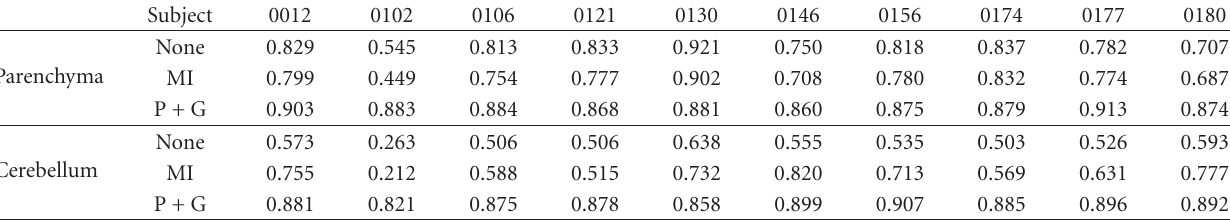
Table 1: Overlap measures comparing the registered segmentation maps against the reference segmentation maps for the parenchyma and cerebellum structure, obtained through without deformation (None), deformable mutual information registration (MI), and our proposed method (P + G).